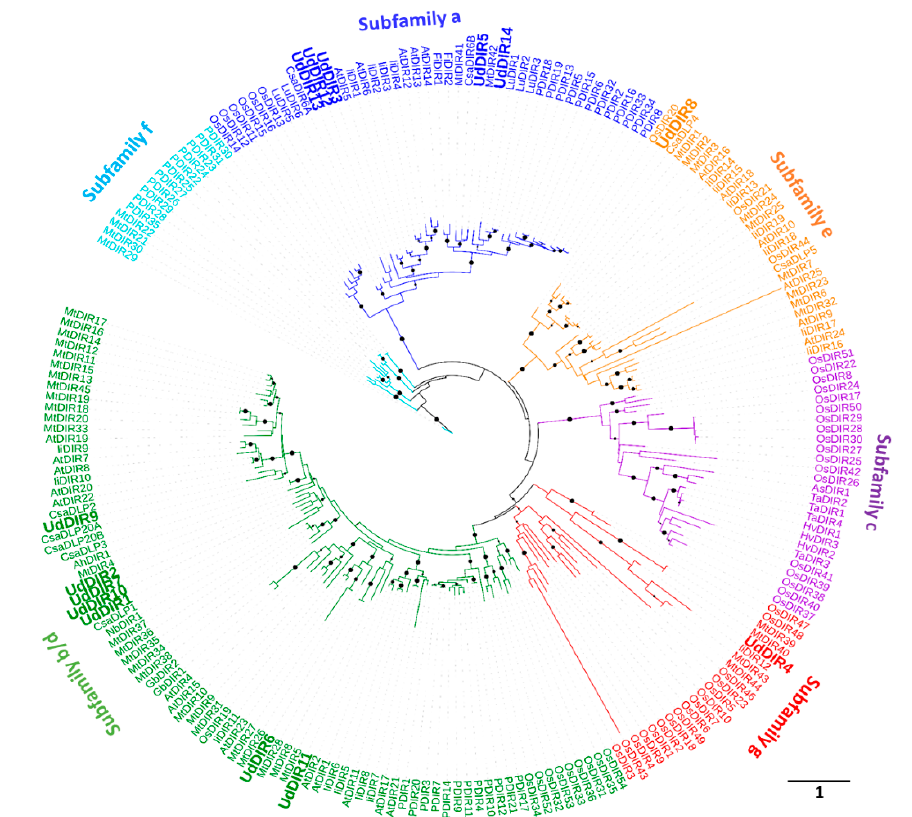
Figure 2. Phylogenetic analysis of DIRs from various plant species. M. truncatula (Mt), A. thaliana (At), C. sativa (Csa), L. usitatissimum (Lu), P. sitchensis (P), O. sativa (Os), A. hypogaea (Ah), A. stolonifera (As), F. x intermedia (Fi), G. barbadense (Gb), N. benthamiana (Nb), T. aestivum (Ta), H. vulgare (Hv)